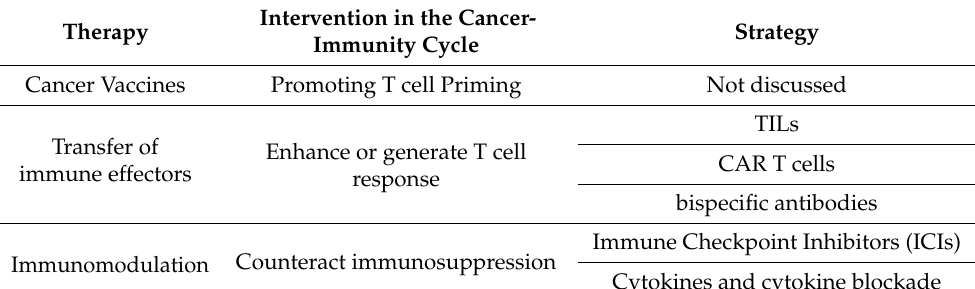
Table 2. Broad classification of immunotherapeutic strategies and respective sites of intervention. Intervention in the Therapy